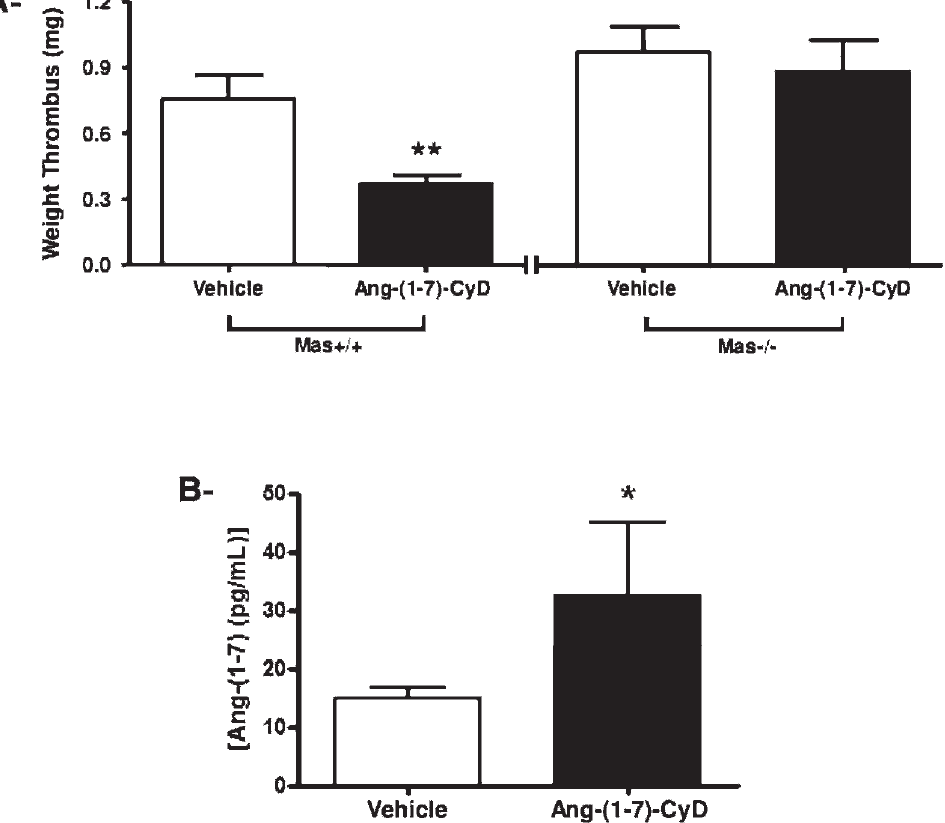
Figure 2 - The antithrombotic effect of Ang-(1-7)-CyD is dependent on Mas. A) Ang-(1-7)-CyD promoted a reduction in FeCl 3 solution- induced thrombus weight in Mas + / + mice; this effect was absent in Mas -/- mice. B) Oral administration of Ang-(1-7)-CyD [equivalent of 100 m g of Ang-(1-7)] increases the plasma level of Ang-(1-7) in C57Bl/6 mice. *p , 0.05 and **p , 0.01 significantly different from the control group treated with CyD (unpaired Student’s t-test). Each column represents the mean ¡ SEM from 6-8